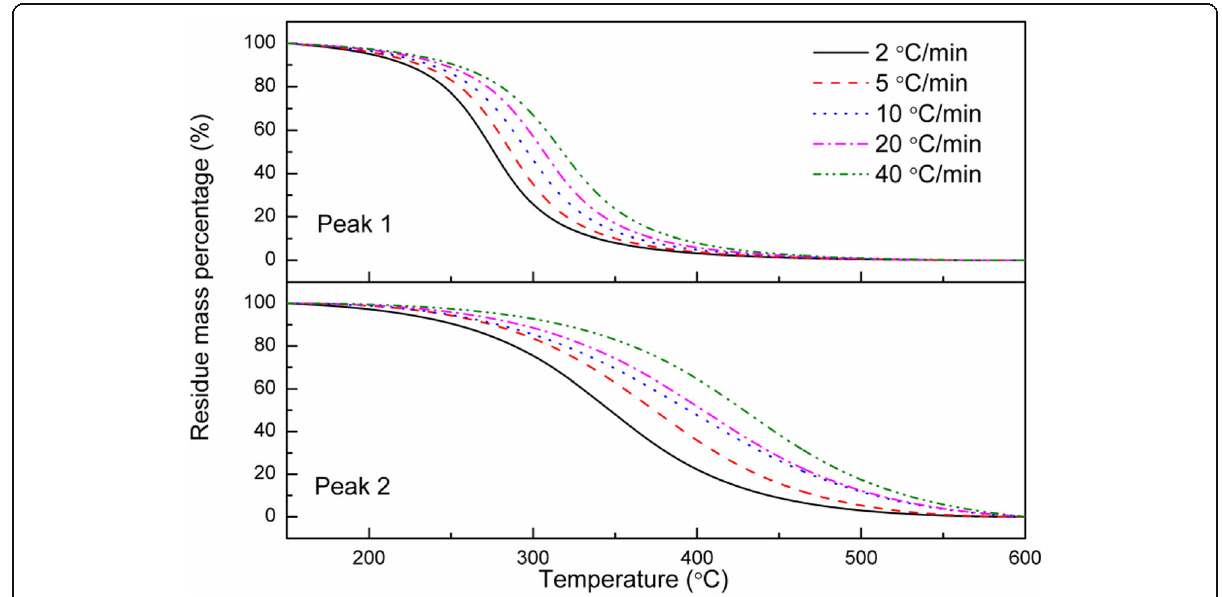
Fig. 5 Sets of reintegrated TG curves corresponding to the first (peak 1, top) and second (peak 2, bottom) degradation